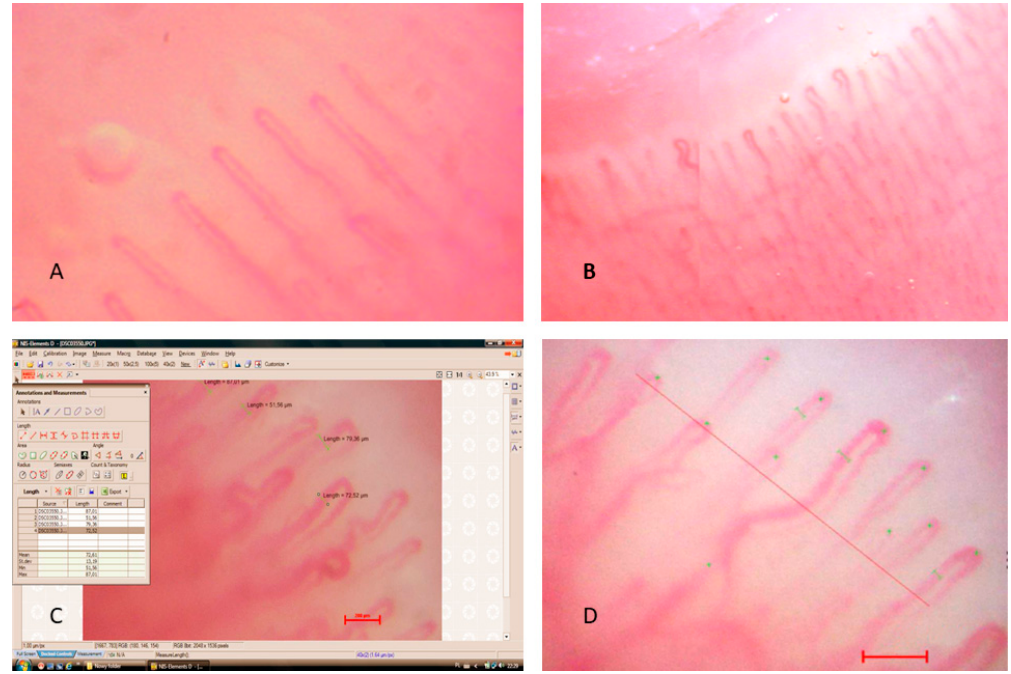
Figure 1. Capillaroscopic pictures of ( A , B ) normal capillary loops, ( C , D ) capillary loops in an example of NIS-ELEMENTS D2.30 computer program window.